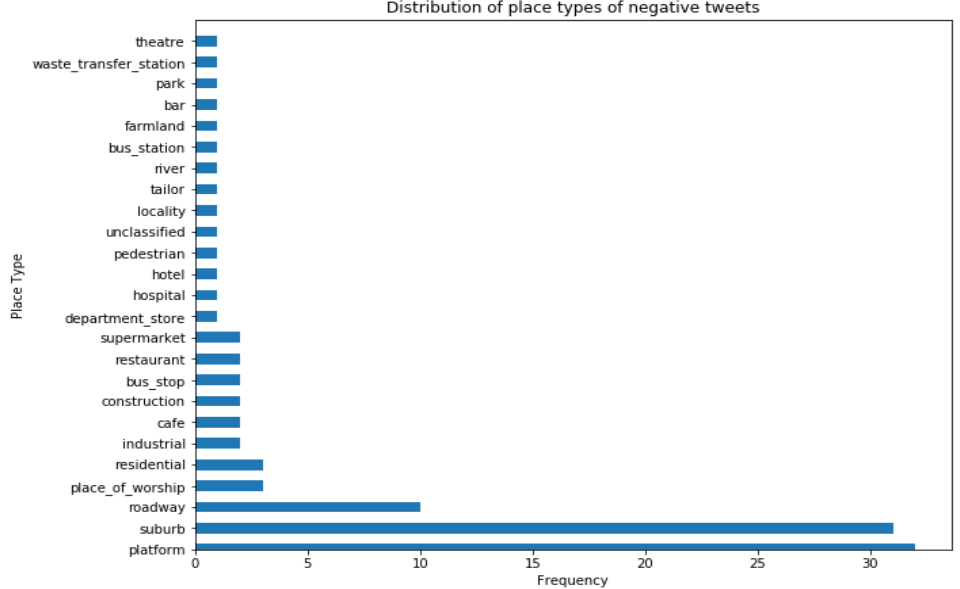
Figure 3. Distribution of negative tweets over different place